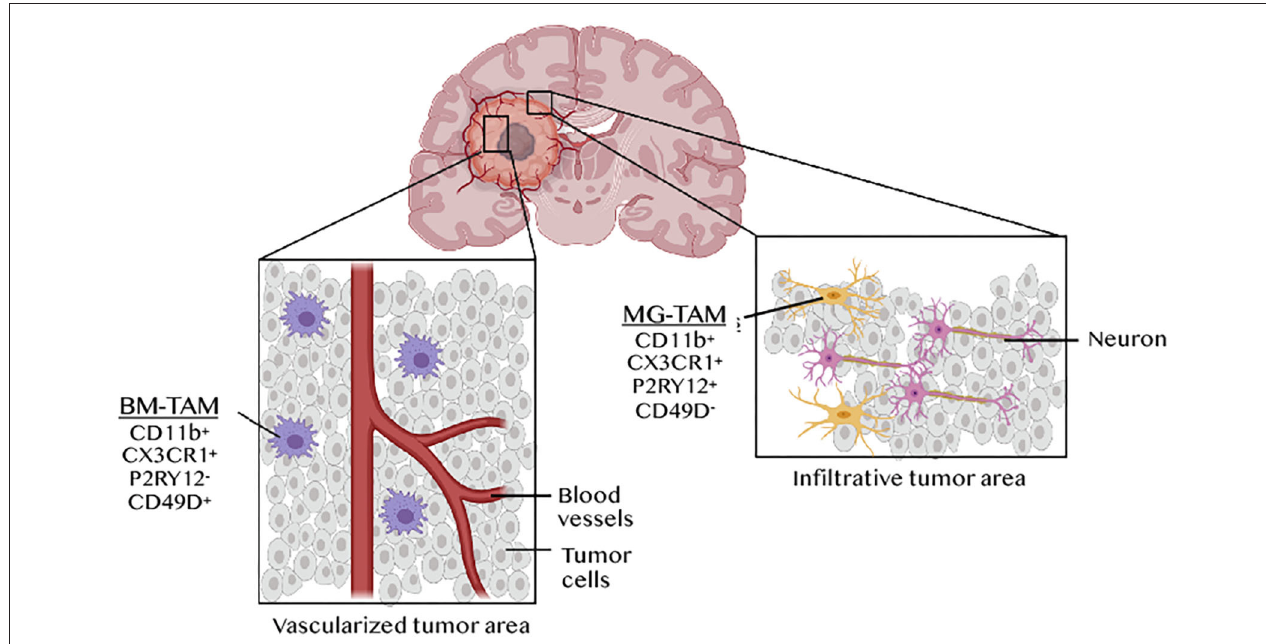
FIGURE 3 | TAM ontogeny and tumor geography in GBM. Tumor-associated macrophages (TAMs) in GBM originates from microglia (MG-TAMs) or from bone marrow-derived monocytes differentiating into macrophages upon recruitment (BM-TAMs). These can be distinguished based on the differential expression of the integrin CD49D on BM-TAMs and of the purinergic receptor P2RY12 on MG-TAMs. BM-TAMs that infiltrate into the tumor core are smaller and less branched than MG-TAMs that are found in the peri-tumoral area.